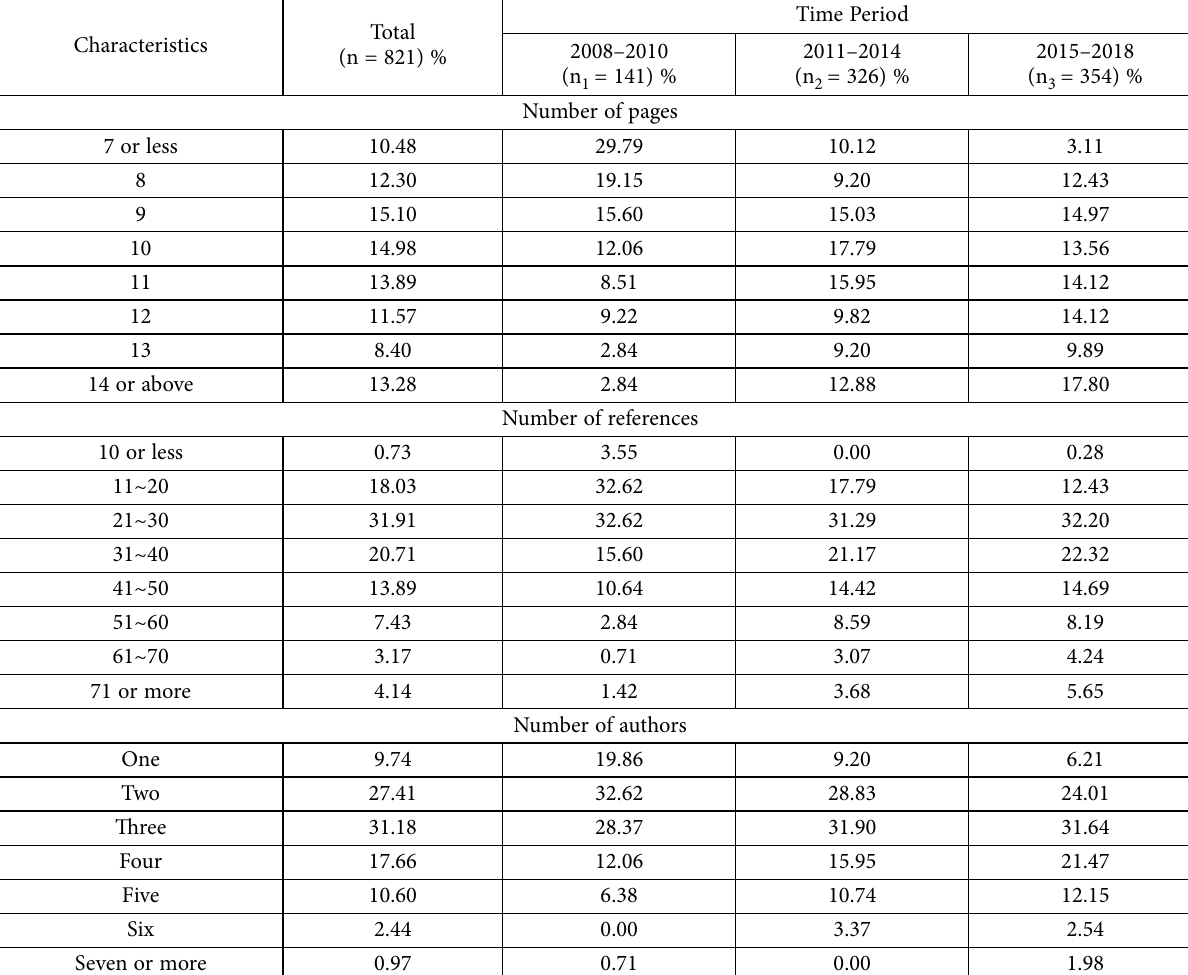
Table 2. Characteristics of the JCEM publications